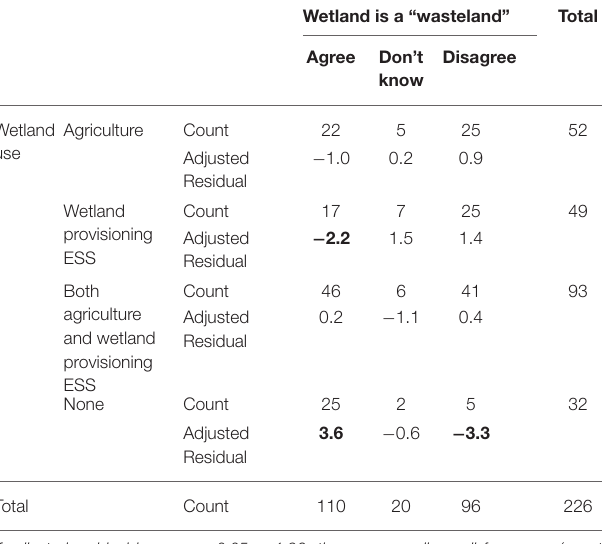
TABLE 5 | Decision routes for determination of wetland conversion to agriculture. Terminal nodes Not cultivating Cultivating